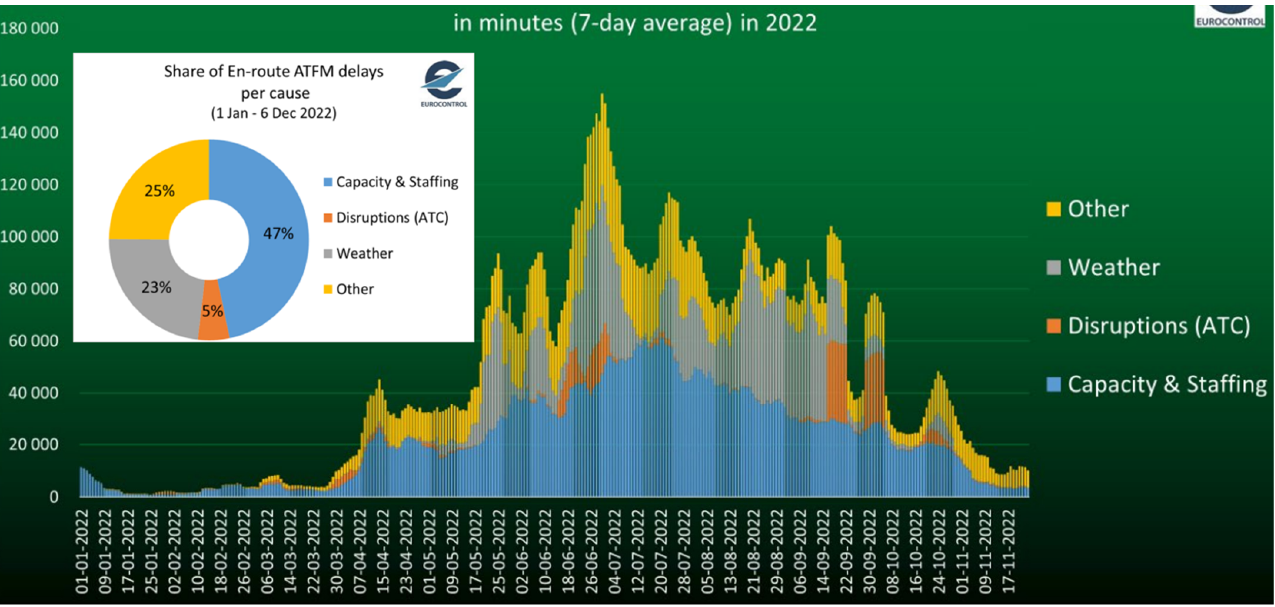
Figure 4. Europe Enroute ATFM Delays in minutes 7 days average Source: Reprinted with permission from EUROCONTROL [39].